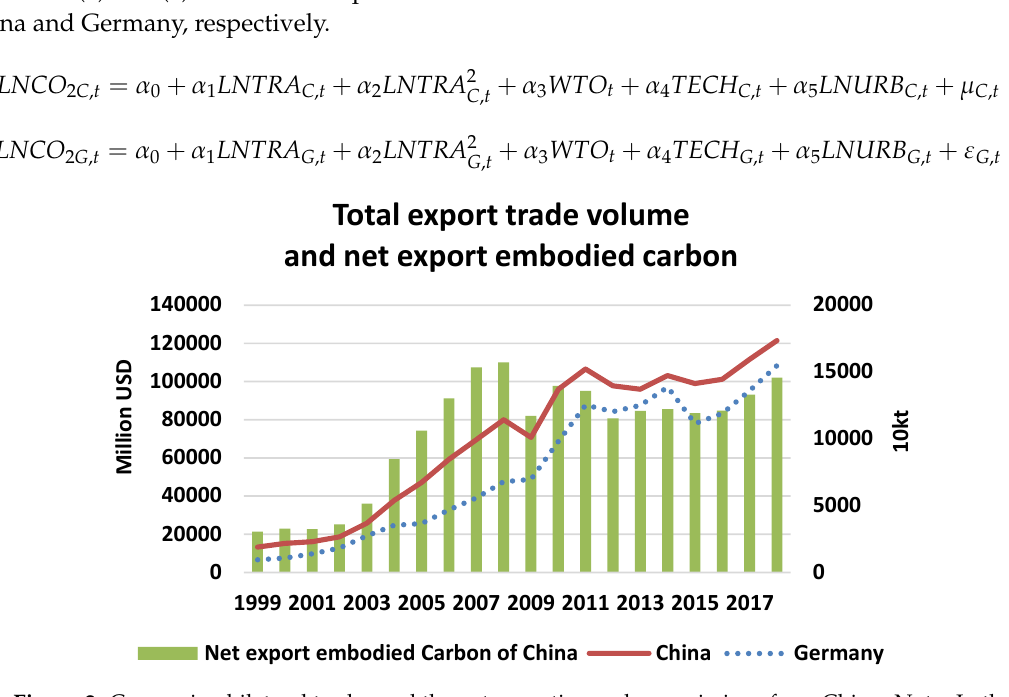
Figure 2. Comparing bilateral trades and the net exporting carbon emissions from China. Note: In the bottom of the graph, “Germany” stands for the export volume of Germany to China, and “China” is the export volume of China to Germany.